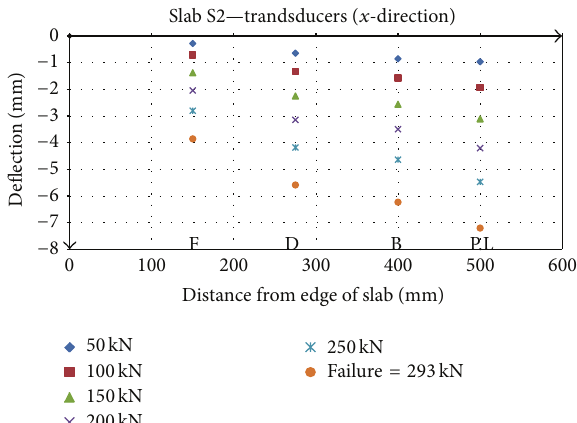
Figure 34: Crack pattern on soffit of slab S2.